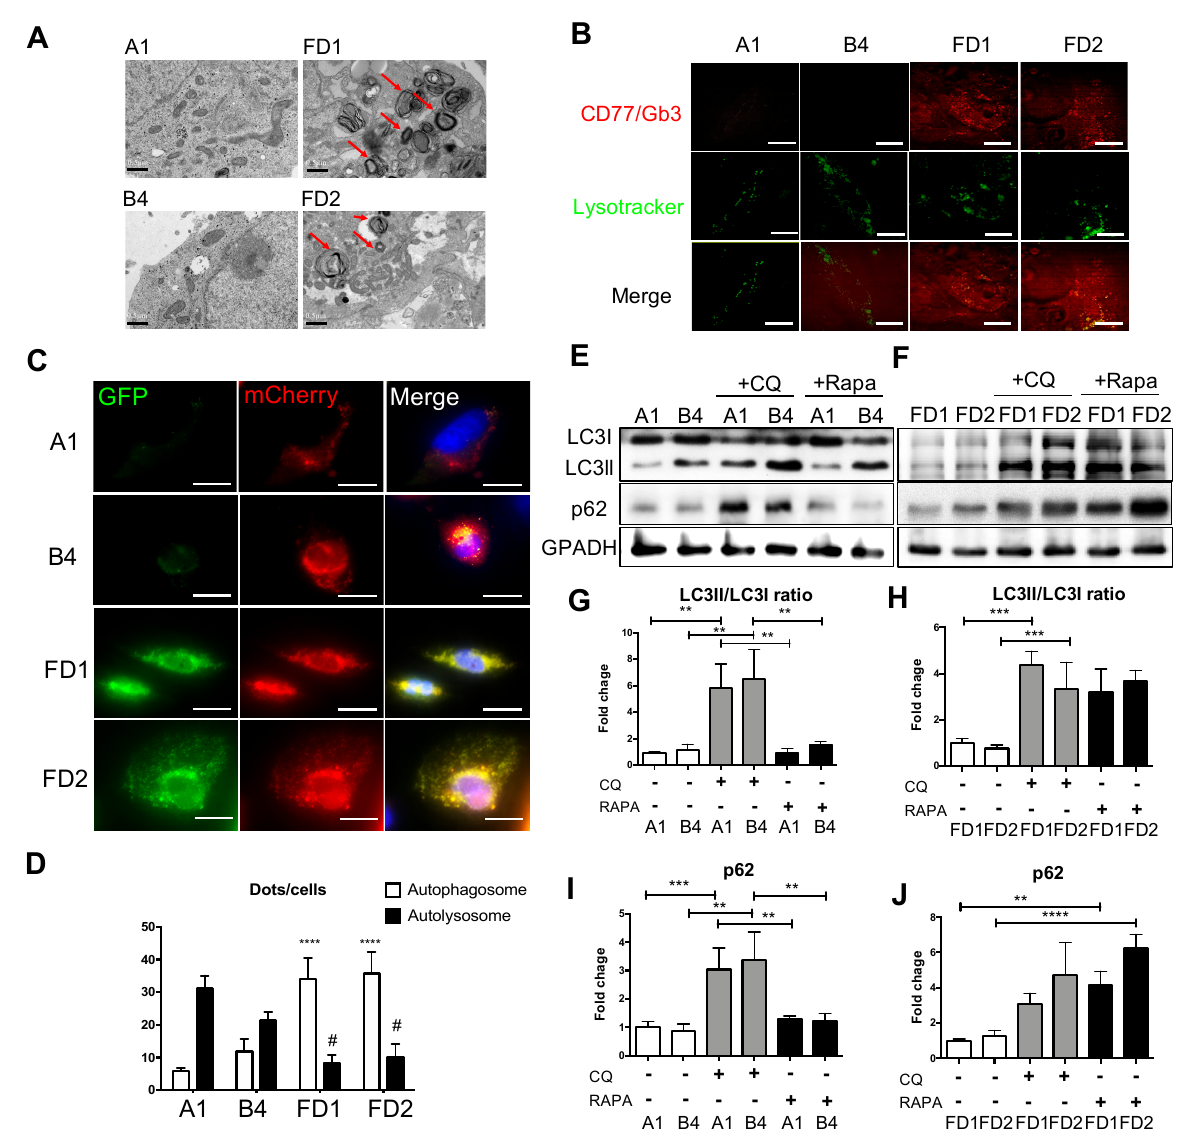
Figure 3. Attenuations of GLA-deficient phenotypic abnormalities in isogenic iPSCs-ECs. ( A ) Ultrastructure of corrected FD and FD-ECs. Arrowheads indicate multilayered lysosome structure. The scale bar is 0.5 µ m. n = 4 images from 4 biological replicates. ( B ) Intracellular Gb3 was immunostained by CD77 in red plots, and lysosome was stained by lysotracker in green plots. The scale bar is 100 µm. n = 4 images from 4 biological replicates. ( C ) Images of iPSC-ECs from corrected FD and FD lines expressing tandem fluorescent mCherryGFP-LC3II (tf-LC3II). The scale bar is 100 µm. n = 30 images from 4 biological replicates. ( D ) Quantification of early and mature AVs in corrected FD and FD-iPSCs derived ECs expressing LC3II. * Compared to corrected FD in autophagosome; # compared to corrected FD in autolysosome. ( E ) Corrected FD and ( F ) FD-ECs were treated with 1uM chloroquine (CQ) or 200 nM rapamycin (Rapa) overnight, and protein levels of light chain 3 (LC3)-I and LC3II were evaluated by Western blot analysis. Quantification of ( G , H ) LC3II/LC3I ratio and ( I , J ) p62 expression levels ( n = 3 images from 3 biological replicates). The scale bar is 100 µm. The error bars represent SD. Unpaired Student’s t -tests were used for statistical analysis (** p < 0.01; *** p < 0.005; **** p < 0.001; # p < 0.05).